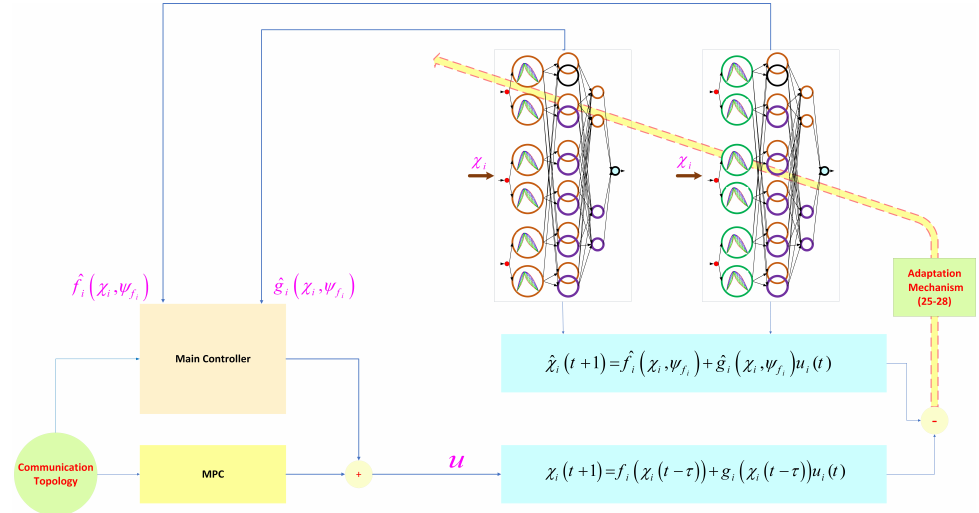
Figure 1. The general scheme of the